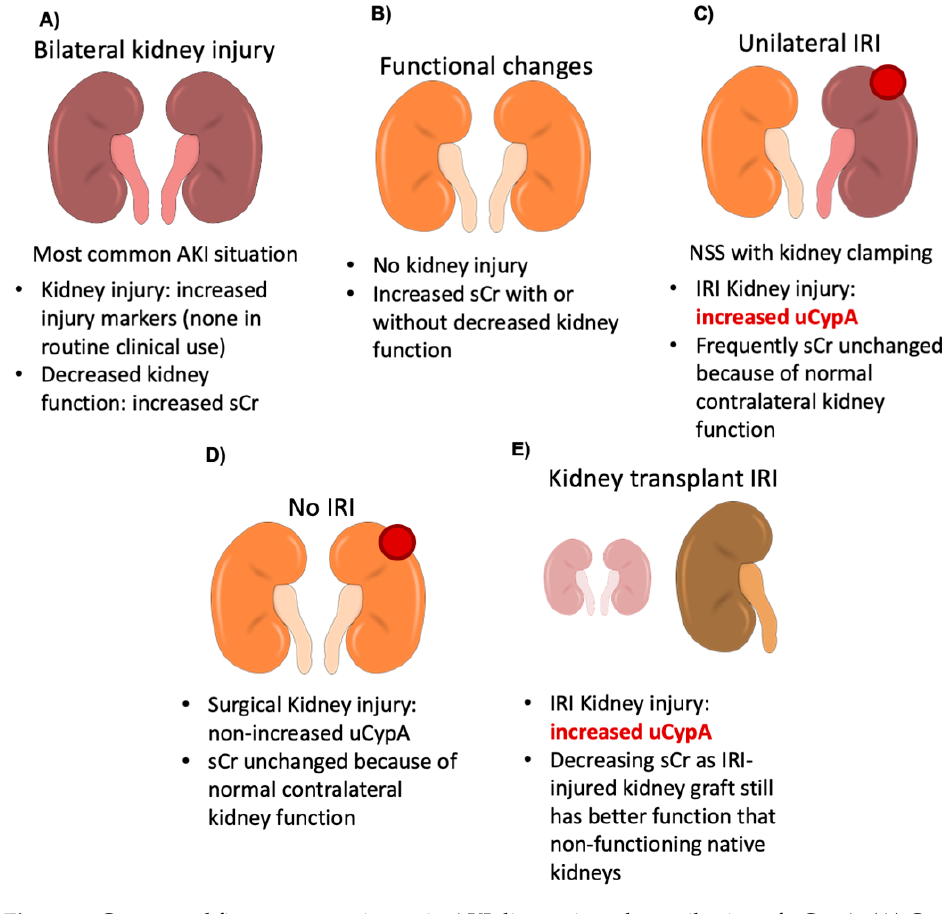
Figure 9. Conceptual figure: current issues in AKI diagnosis and contribution of uCypA. ( A ) Current AKI diagnosis. ( B ) sCr may increase due to functional reasons, in the absence of injury. ( C ) Unilateral IRI resulting from clamping of renal artery in NSS. Increased uCypA in IRI kidney injury. uCypA was a more sensitive marker of IRI-induced kidney injury than sCr or classical markers of injury such as NGAL. ( D ) In NSS without clamping, there is no IRI. ( E ) In KT patients, kidney graft IRI is usually associated with decreasing sCr levels. Increased uCypA in IRI kidney injury. Again, uCypA provided evidence of kidney injury despite decreasing sCr and non-informative uNGAL.